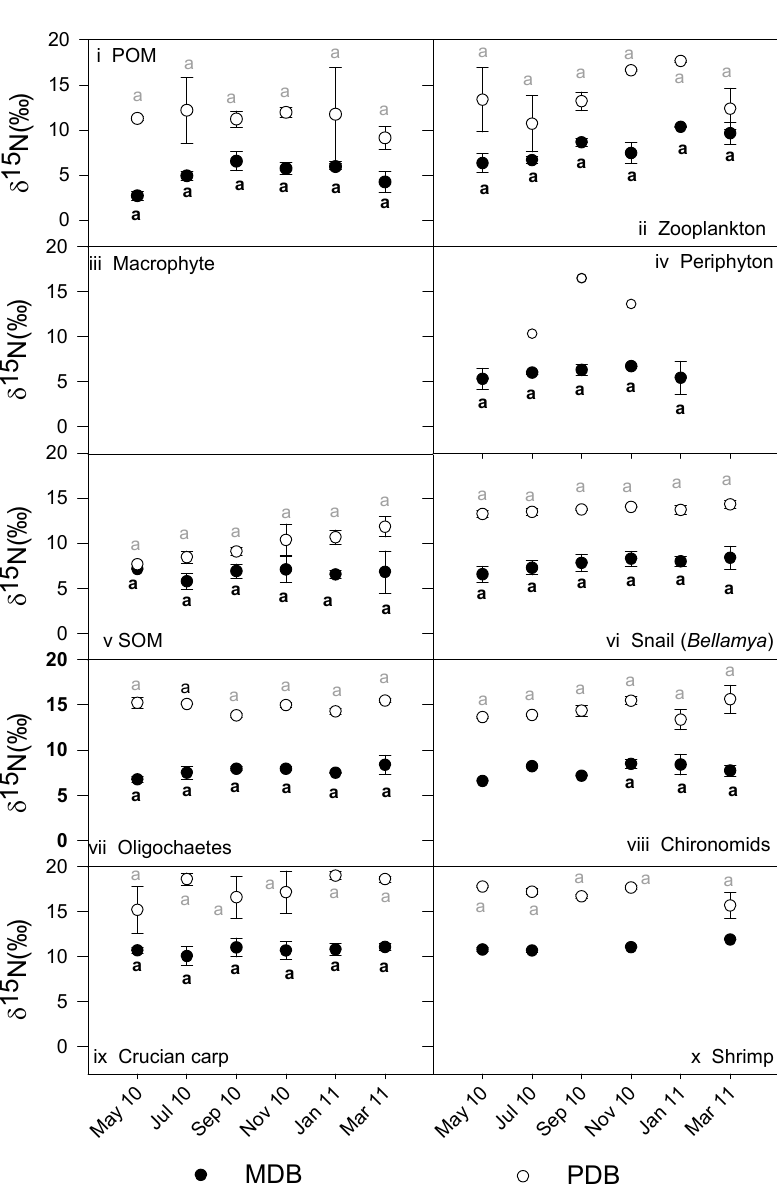
Figure 5. Repeated measures of δ 15 N (‰) in food sources, invertebrates, and fish in MDB and PDB during the period April 2010 to March 2011. Gray and bold letters show the results of seasonal variation analysis using Bonferroni’s Multiple Comparison Test in PDB and MDB.